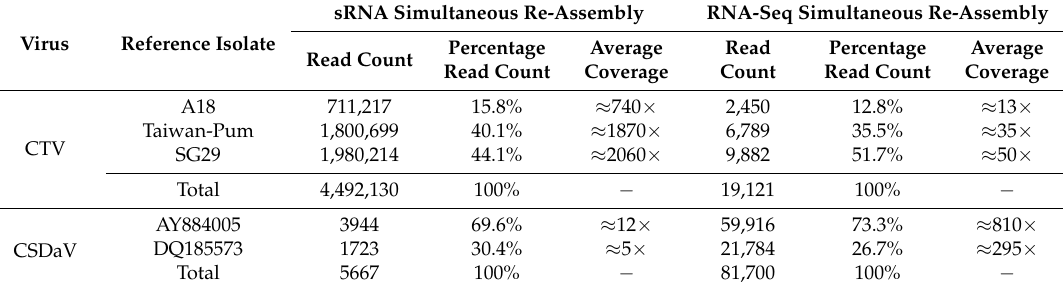
Table 4. Comparison of the re-assembly data for the two dominant virus species identified in this study (Citrus tristeza virus; CTV and Citrus sudden death-associated virus; CSDaV). Read counts from the simultaneous re-assembly analysis are shown for the three assumed predominant CTV isolates and for the two CSDaV